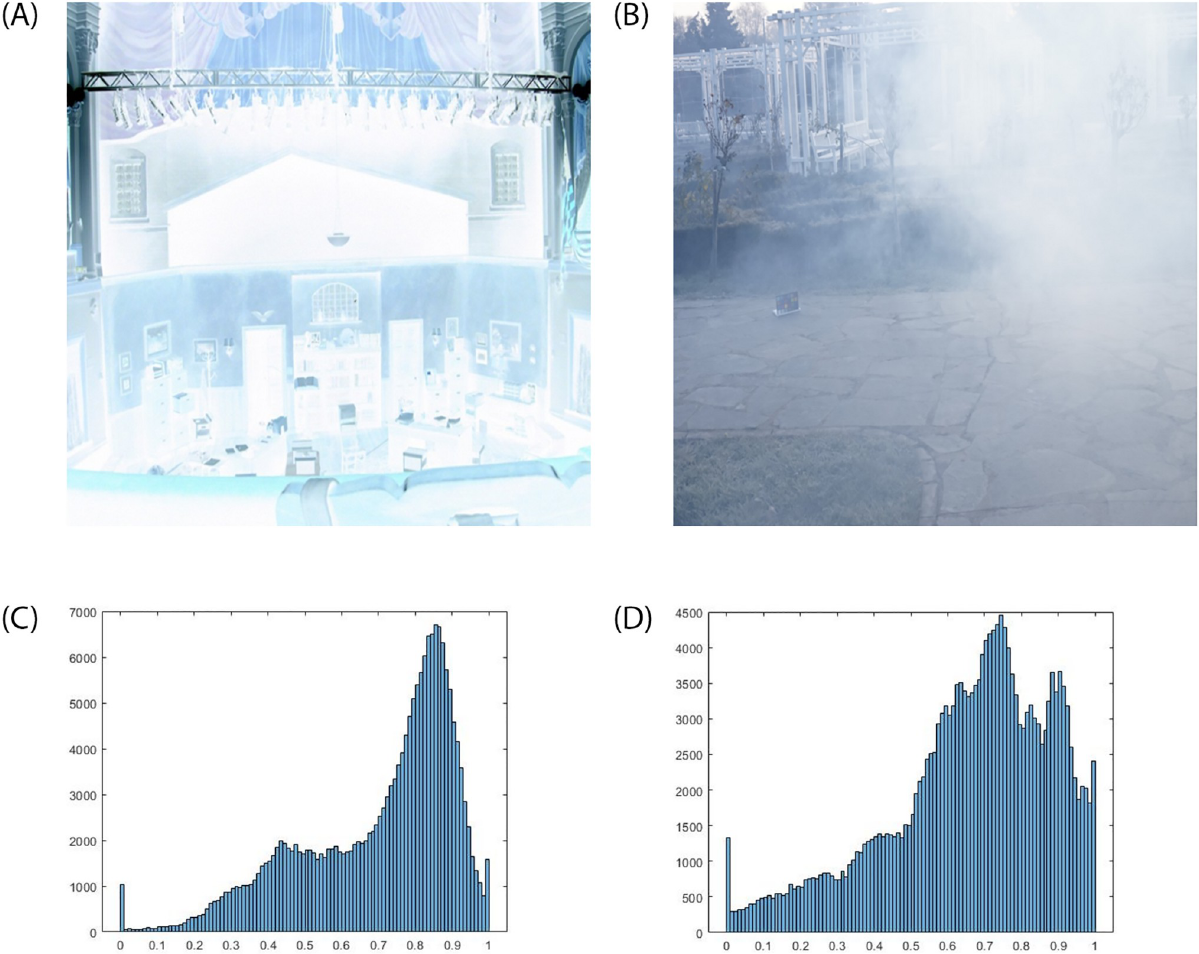
Fig 1. Average histogram for the 40 random hazy images from [8] dataset (1a) and similar low-light photos from the GLADNet [9] dataset (1b). After performing the inversion upon the low-light pictures, we can see similar trends in the histogram of the transformed (1c) and hazy images (1d). This statistical phenomenon influenced the proposed study to incorporate haze distribution theory for image restoration. (a) Inverse low-light image, (b) Hazy image, (c) Average histogram of inverse low light images, and (d) Average histogram of hazy images.